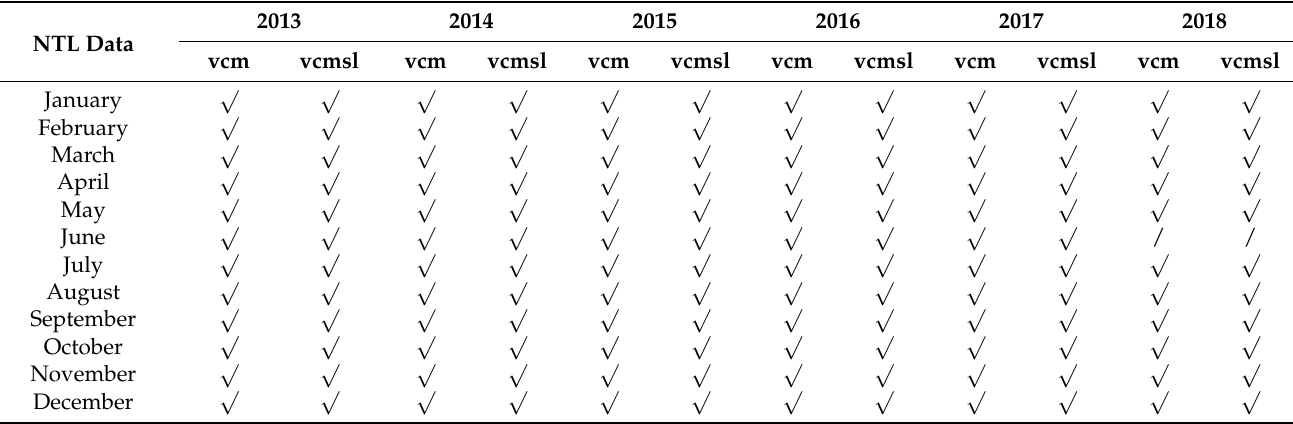
Table 1. Two versions of available monthly VIIRS images, vcm (any data impacted by stray light were excluded) and vcmsl (stray light-impacted data were corrected) during